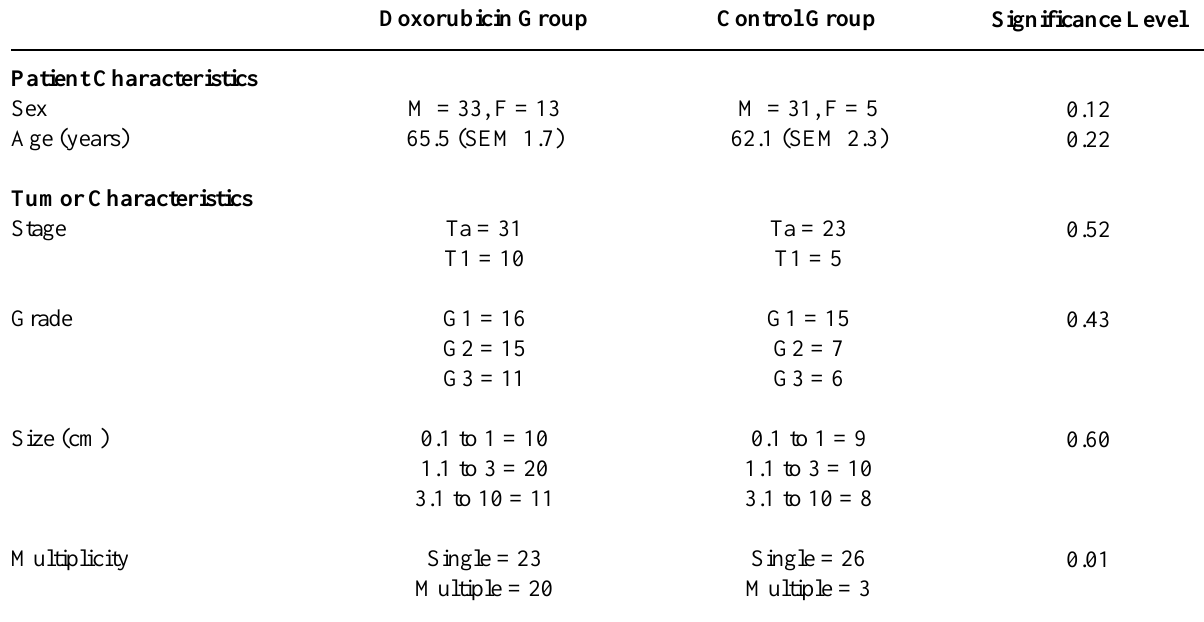
Table 1 – Distributions of patient and tumor